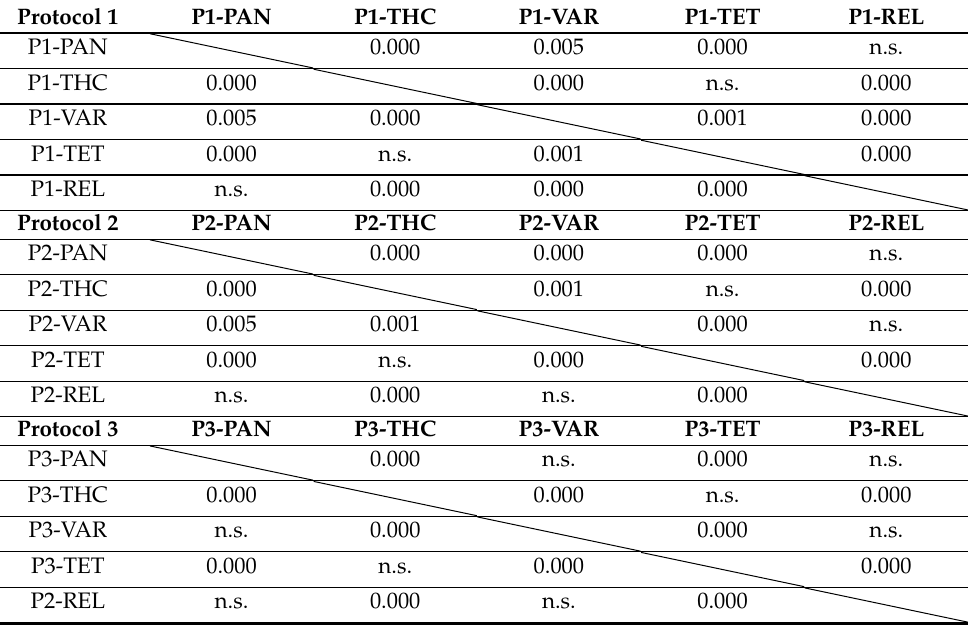
Table 2. Effect of cement in each moulding method, with p values showing significant differences between the mean bond strength values (MPa) of the resin-based cement to the zirconia surface in Protocols 1–3. For groups’ abbreviations, see Table